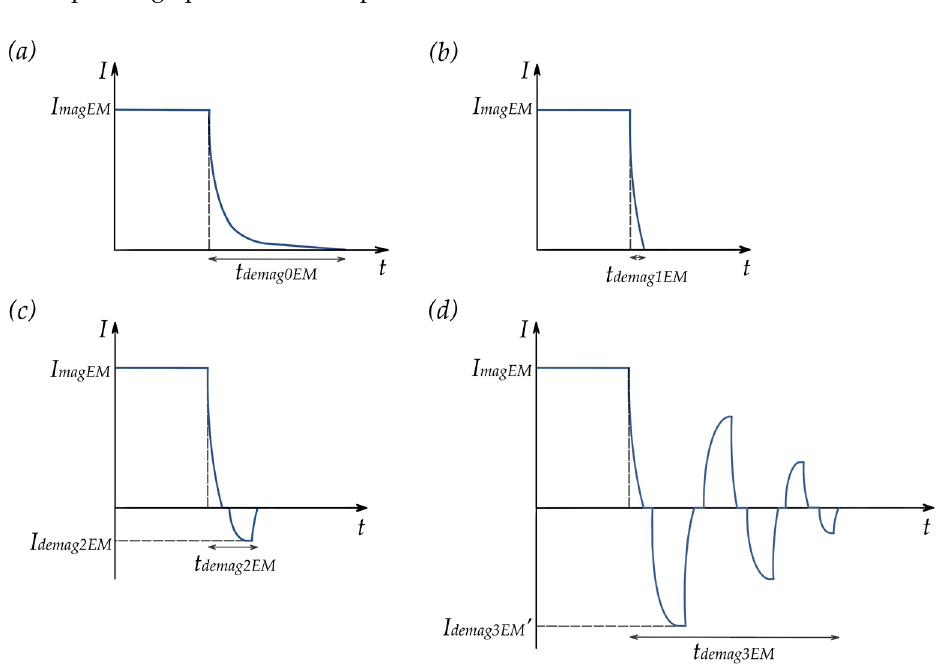
Figure 7. Qualitative trends of the current for the four types of demagnetization phases: ( a ) demag- netization 0, ( b ) demagnetization 1, ( c ) demagnetization 2, ( d ) demagnetization